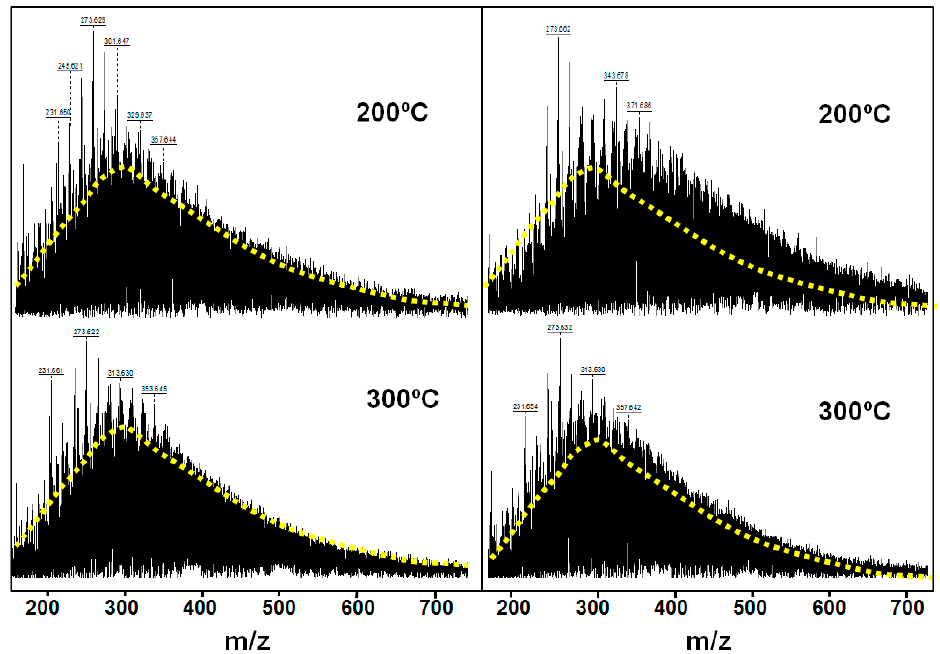
Figure 3. MALDI spectra of resins from rock extracts under various influence temperatures for 12 h in the absence ( left ) and presence ( right ) of a catalyst. Punctuated lines indicate the distribution of molecular masses with respect to specters of experiments at 200 °C without a catalyst.